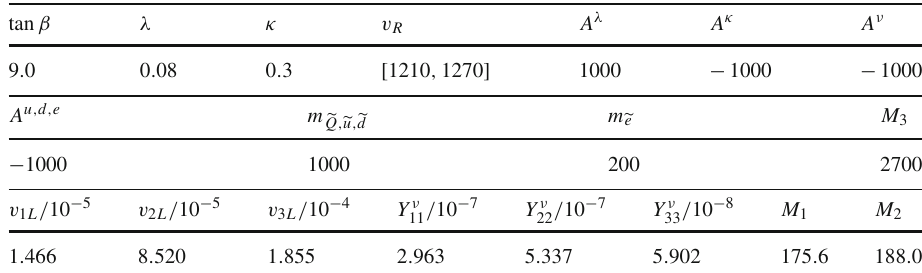
Table 3 The same as in Table 2 for the scan over v R = v